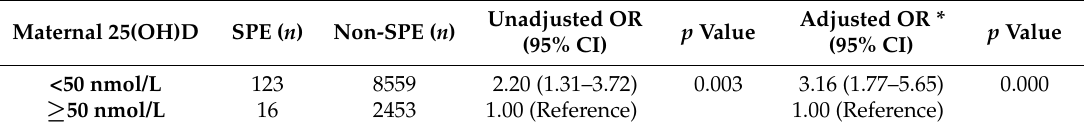
Table 5. Unadjusted and adjusted ORs for severe preeclampsia according to maternal vitamin D at 23–28 weeks of gestation. Maternal 25(OH)D SPE ( n